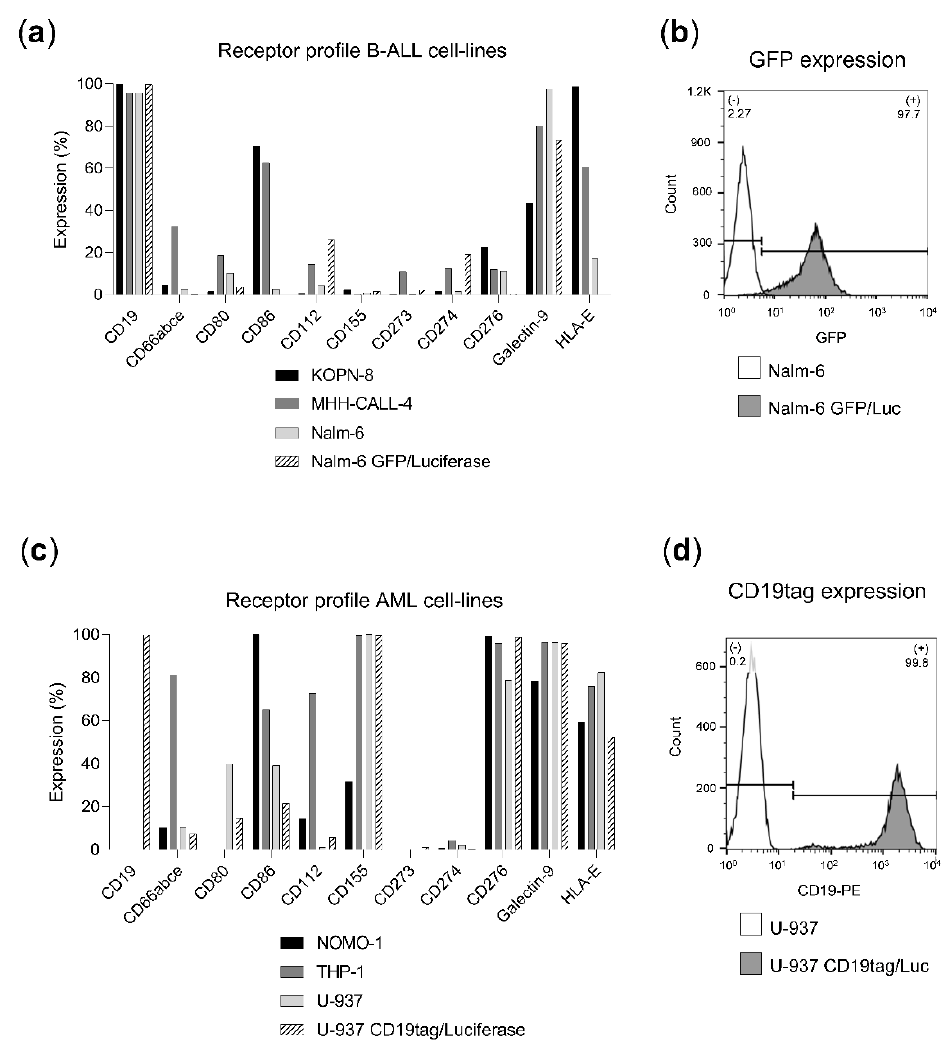
Figure 1. Ligand profile characterization of leukemia cell lines. Percentage of ligand or GFP-expressing cells was determined by flow cytometry. ( a ) Ligand expression in B-ALL cell lines (KOPN-8, MHH-CALL-4, Nalm-6 and Nalm-6 GFP/Luc). ( b ) GFP expression of Nalm-6 GFP/Luc (grey) in comparison to non-transduced Nalm-6 (white). ( c ) Ligand expression in AML cell lines (NOMO-1, THP-1, U-937 and U-937 CD19tag/Luc). ( d ) CD19 expression of U-937 CD19tag/Luc (grey) in comparison to non-transduced U-937 (white).